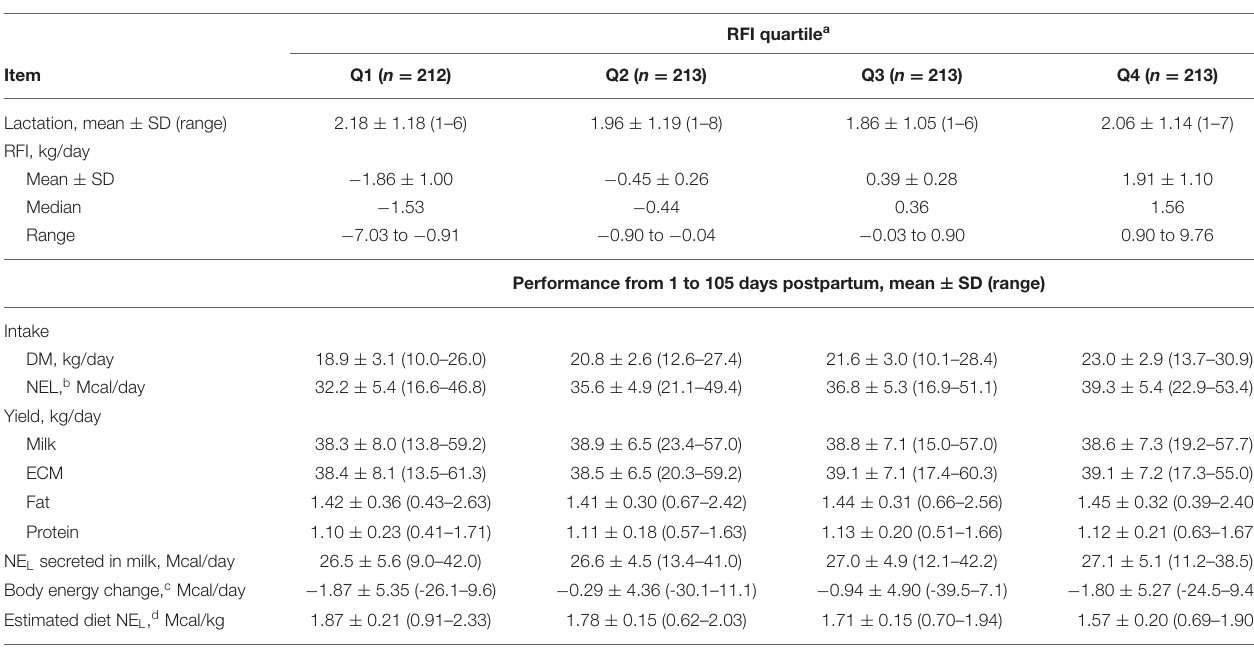
TABLE 1 | Descriptive statistics of performance of dairy cows from 1 to 105 days postpartum according to residual dry matter (DM) intake [residual feed intake (RFI)] quartile.